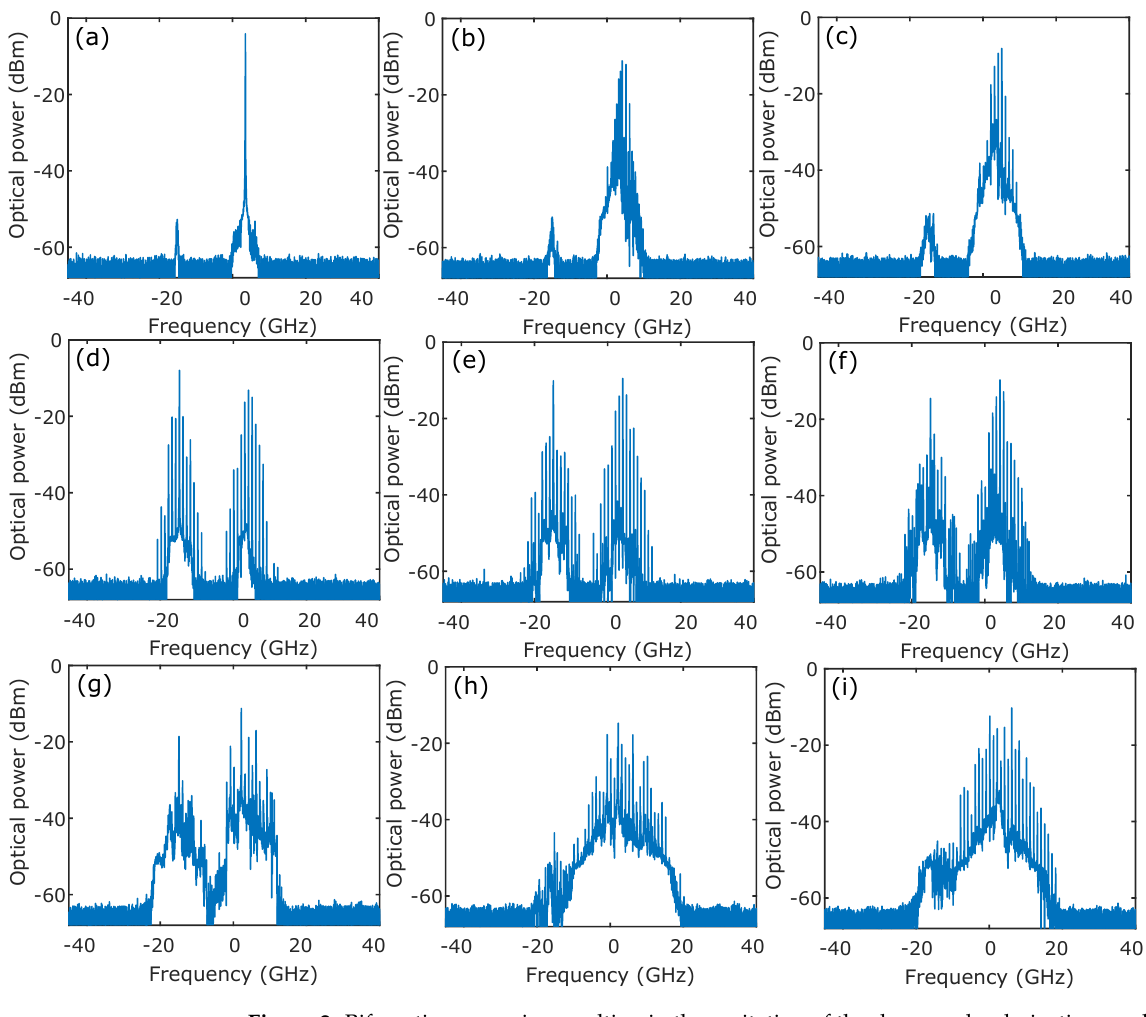
Figure 2. Bifurcation scenarios resulting in the excitation of the depressed polarization mode. These optical spectra are obtained for detuning ∆ ν = 1.6 GHz and injected comb spacing Ω = 1 GHz when increasing the injected power, P inj . ( a ) Stable output at P inj = 3 µW, ( b , c ) wave mixing at P inj = 16 µW and P inj = 32 µW, respectively, ( d ) two polarization comb at P inj = 48 µW, ( e , f ) two polarization harmonics comb at P inj = 80 µW and P inj = 96 µW, respectively, ( g ) two polarization complex dynamics at P inj = 128 µW and ( h , i ) X-polarization comb at P inj = 144 µW and P inj = 240 µW, respectively.